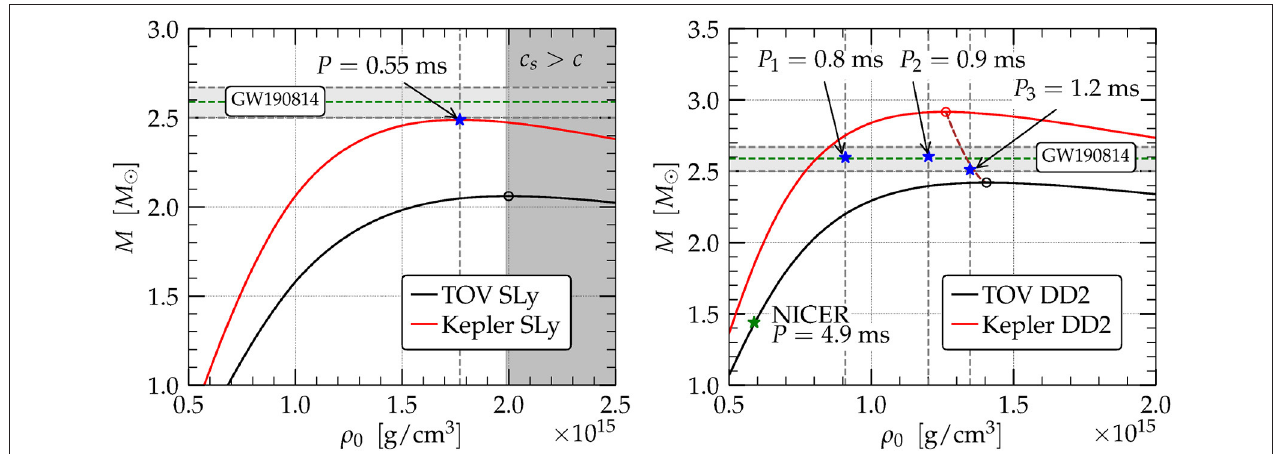
FIGURE 4 | Two possibilities for the EOS of a NS companion in GW190814. The scenario on the left, which employs the SLy (soft) EOS, fails to provide a model for a uniformly rotating star, even at maximum uniform rotation. On the contrary, the scenario on the right that employs the DD2 (stiff) EOS succeeds and demonstrates the possibility of a slowly rotating NS. The lower (black) curves represent spherical, non-rotating models, while the upper (red) curves represent uniformly rotation models spinning at the Keplerian (mass-shedding) limit (from Tsokaros et al.,